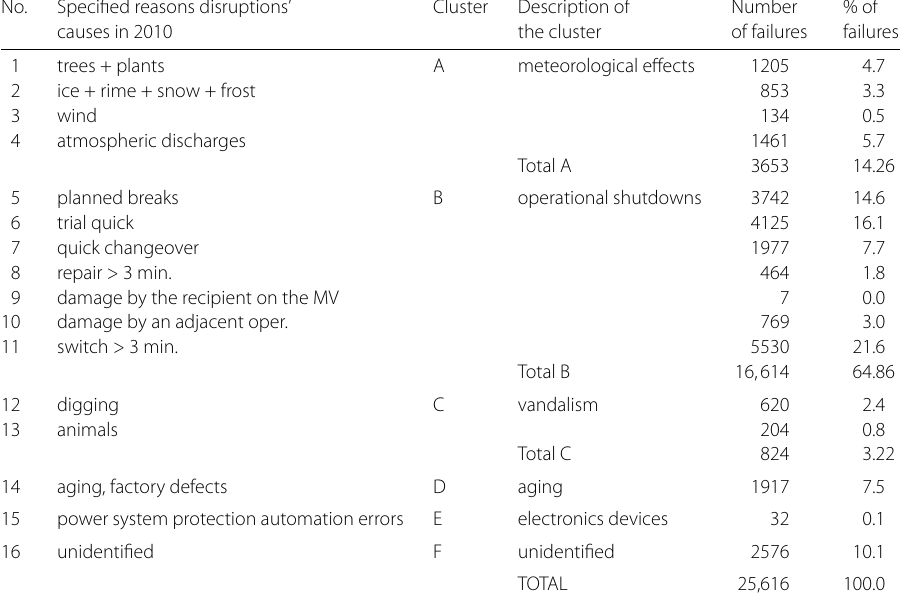
Table 2 Electrical grids disruptions’ causes in southern Poland distribution network in 2010